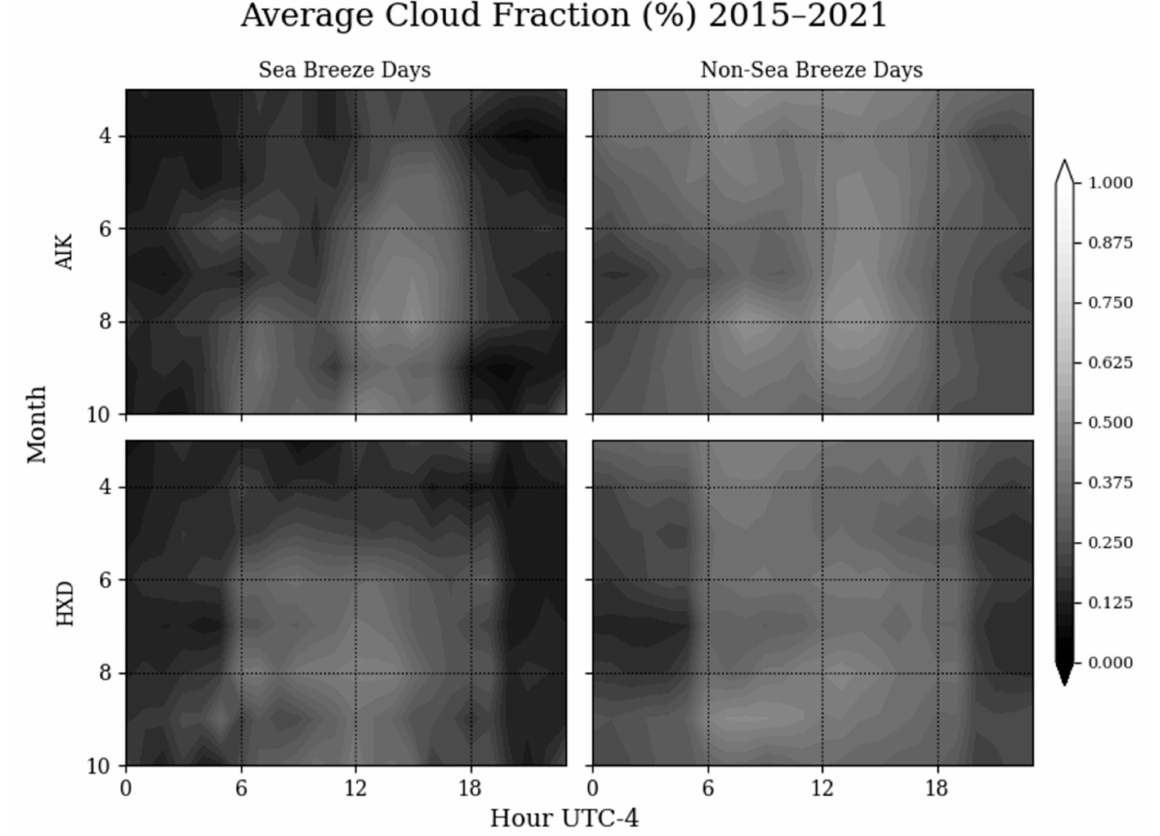
Figure 6. Average cloud fraction by month and by hour for inland (Aiken) and coastal (Hilton Head) weather